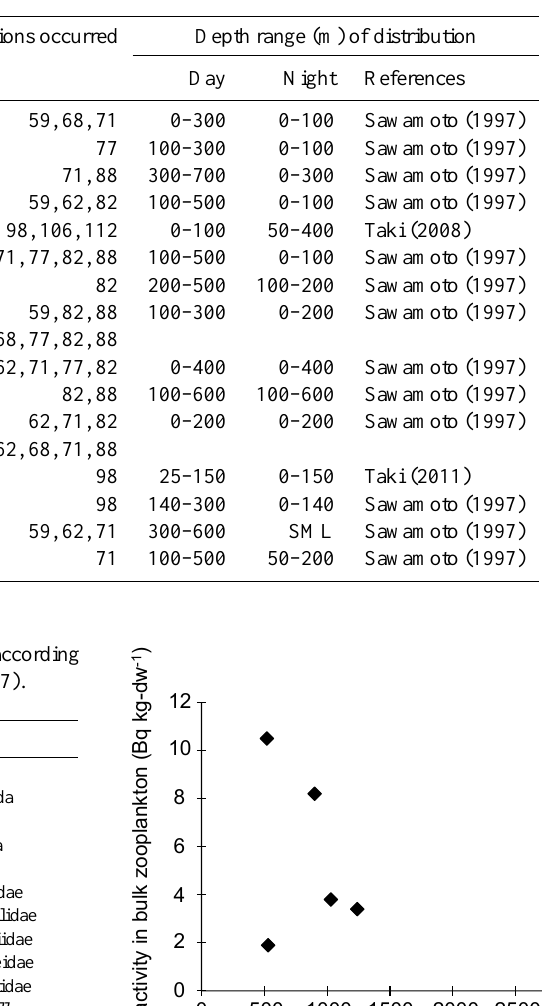
Table 4. Occurrences of Euphausiacea in western North Pacific Ocean 10 months after the FNPP1 accident with notes on their vertical distri- bution during the day and the night. Asterisks show diel vertical migratory species. Euphausia spp. and Stylocheiron spp. were unidentified juvenile or damaged specimens. SML means surface mixed layer.